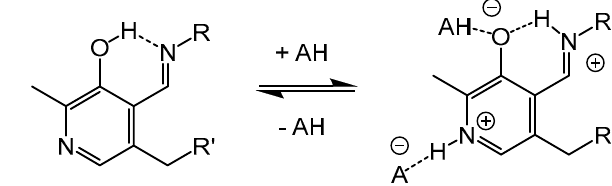
Figure 6. Schematic structure of ortho -hydroxy Schiff bases 8 , formed by PLP, studied by NMR ([59] and references cited therein). and references cited